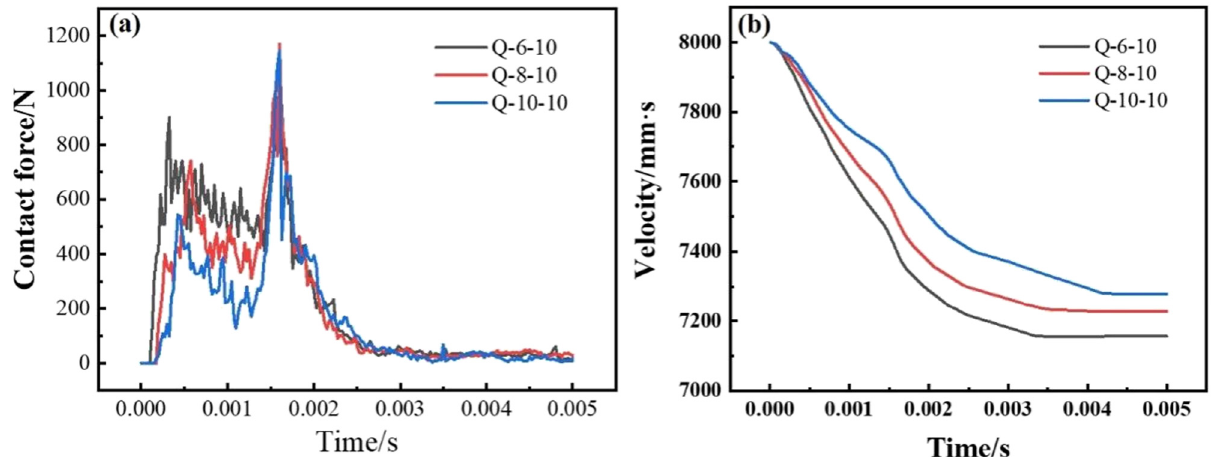
Figure 3: Comparison between contact force – time and velocity – time curves of Q - 6 - 10, Q - 8 - 10, and Q - 10 - 10. ( a ) Contact force – time curves and ( b ) velocity – time